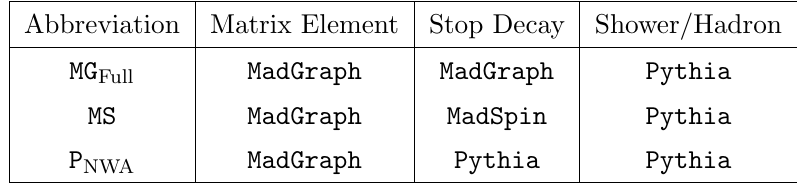
Table 1 . The naming conventions for the various event generation tools